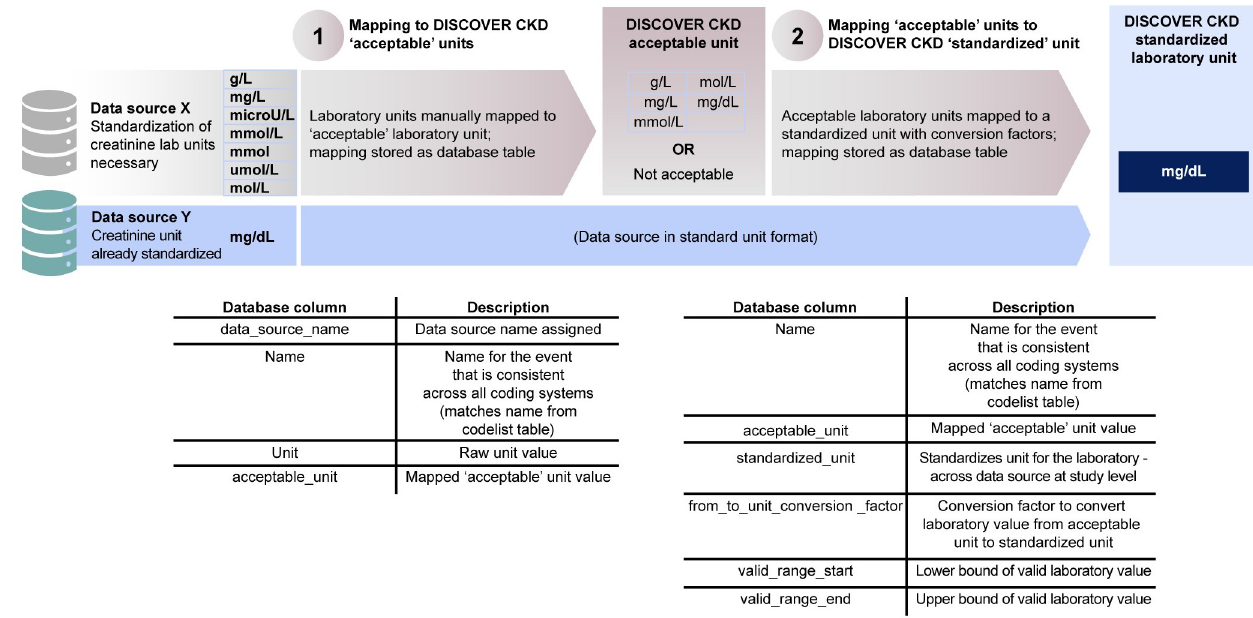
Fig 3. Example laboratory unit harmonization: Creatinine units. Acceptable units were defined as any unit that was valid for the laboratory and could be converted to the standardized unit. CKD, chronic kidney disease.